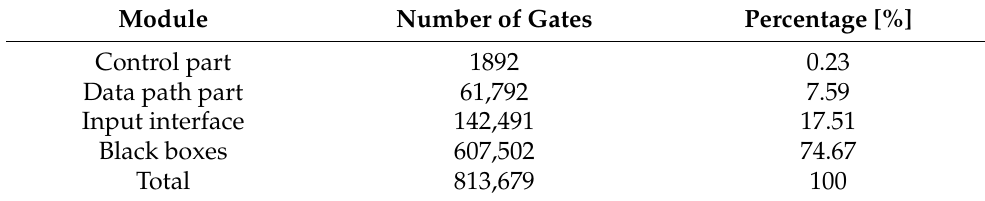
Figure 10. The schematic view after synthesis: ( a ) the data path part, control part, and input interface, ( b ) the expanded view. Table 8. Resource usage of the designed